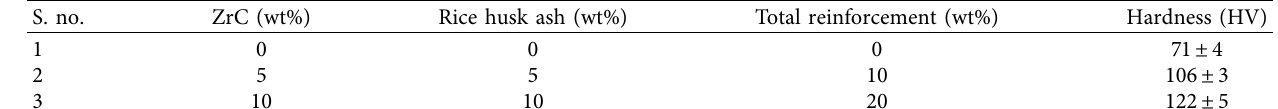
Table 4: Impact on the hardness.